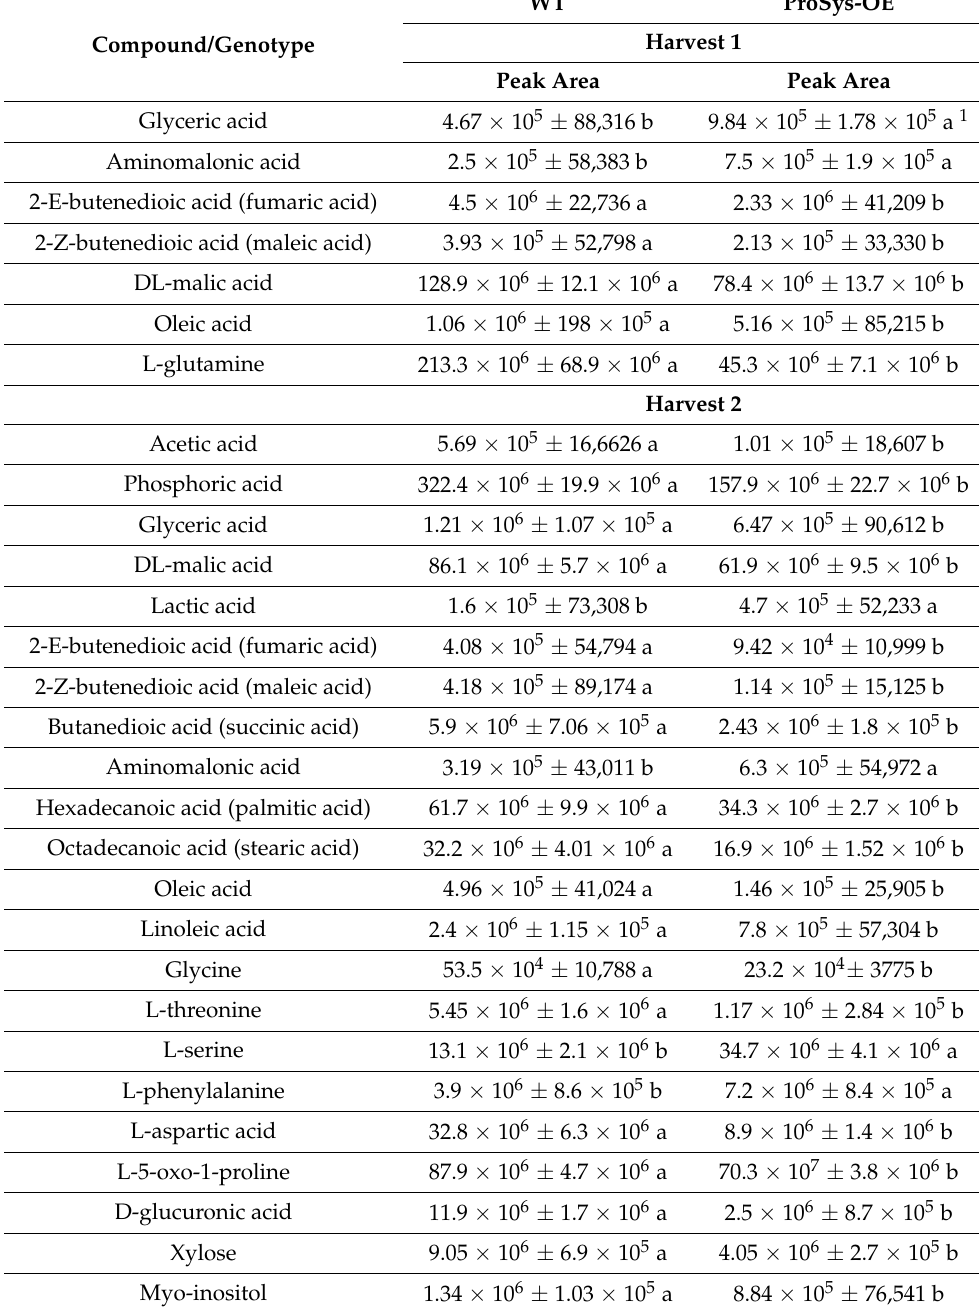
Table 4. Metabolites analysis of tomato fruits harvested from wild-type (WT) and prosystemin overexpressing (ProSys-OE) plants. The analysis was performed in fruits collected from WT un- transformed plants and from plants overexpressing the ProSys precursor protein of the systemin peptide hormone. The metabolites listed correspond to those that were detected to accumulate to significantly different levels in fruits of either WT or ProSys-OE plants. They were identified by a targeted GC-MS analysis of fruits obtained from the first (1) and second (2) seasonal